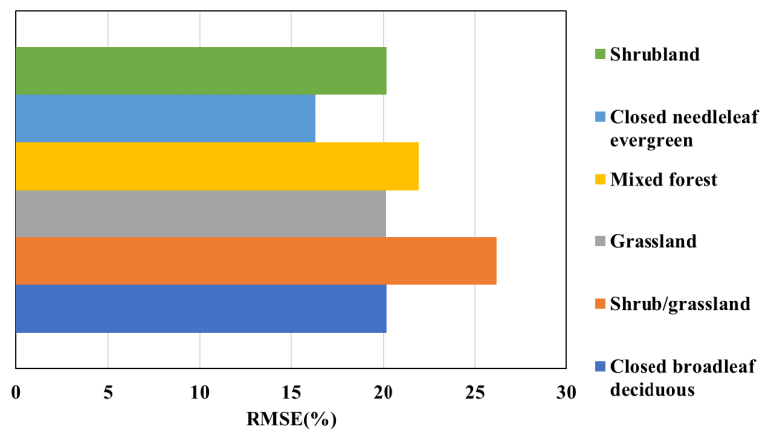
Figure 7. RMSEs of LFMC retrieval results for different vegetations.